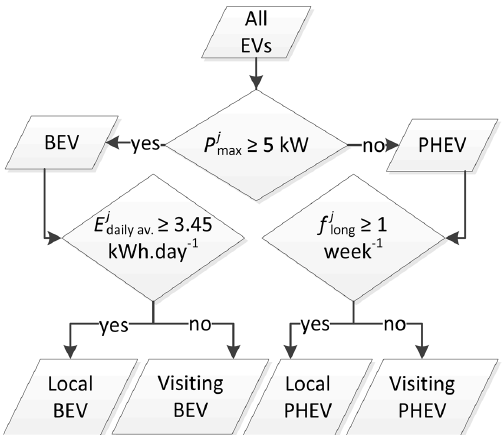
Figure 2. Categorization of electric vehicles (EVs), in which P j max is the maximum charging power of EV j, 𝐸 is the average amount of energy charged for EV j per day, and 𝑓 is its frequency of transactions with a duration >6 h.